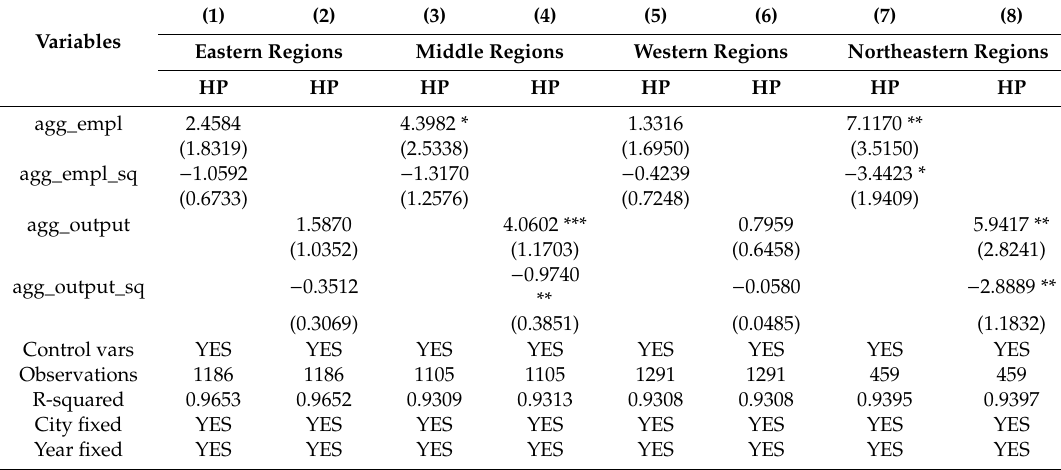
Table 4. Heterogeneous